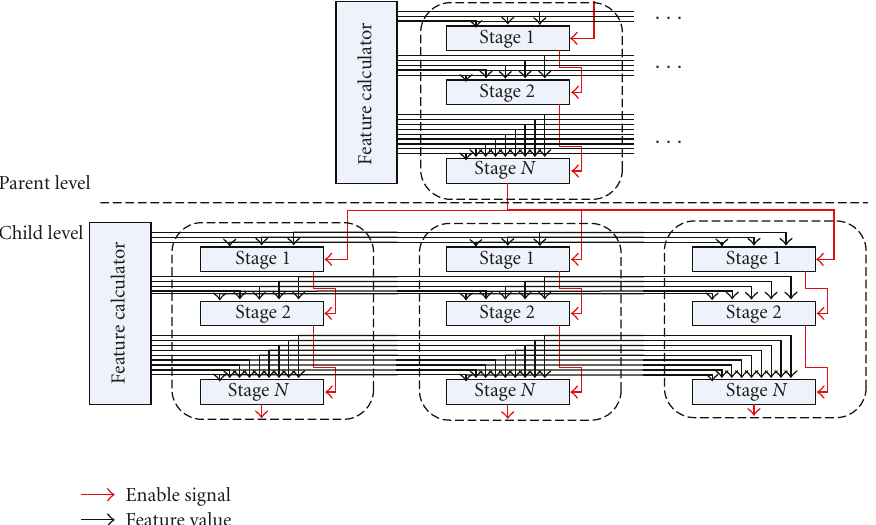
Figure 6: Structure of detector nodes and their